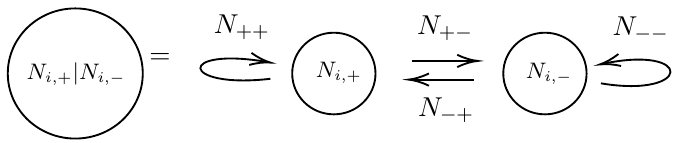
Figure 1 . Quiver gauge theory interpretation of supergroup gauge